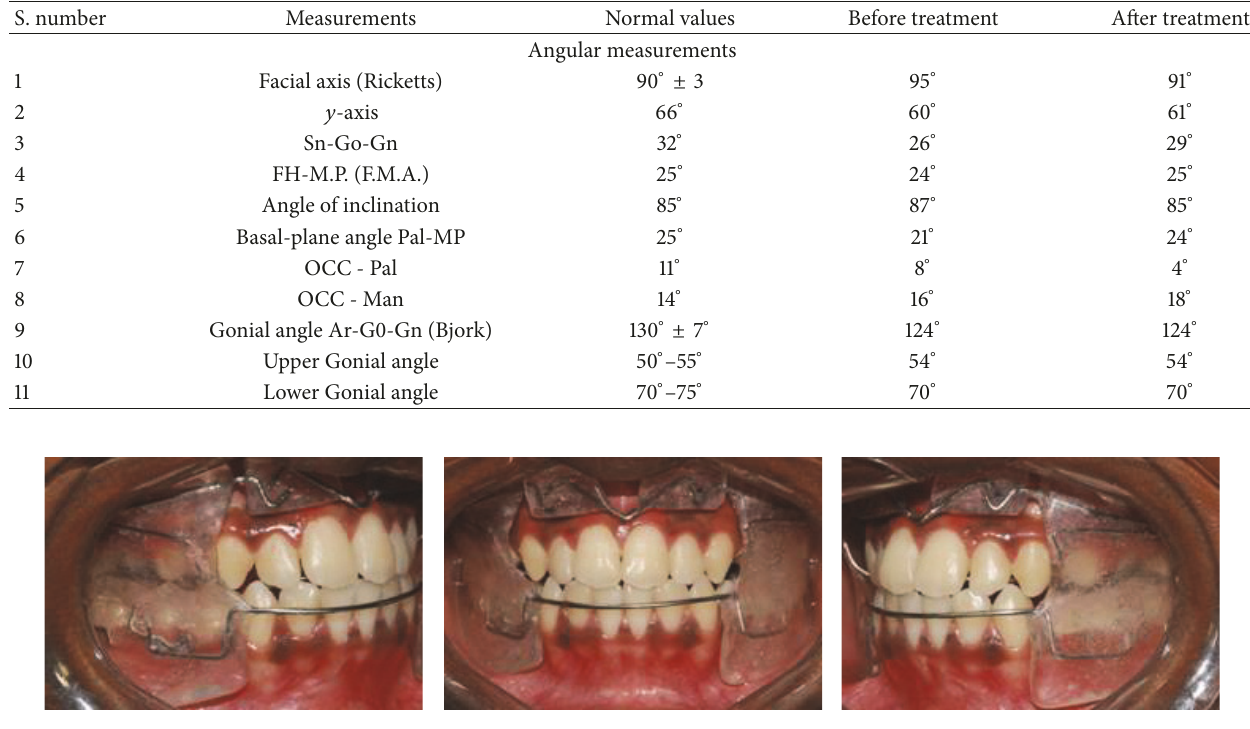
Table 2: Comprehensive cephalometric evaluation (vertical).